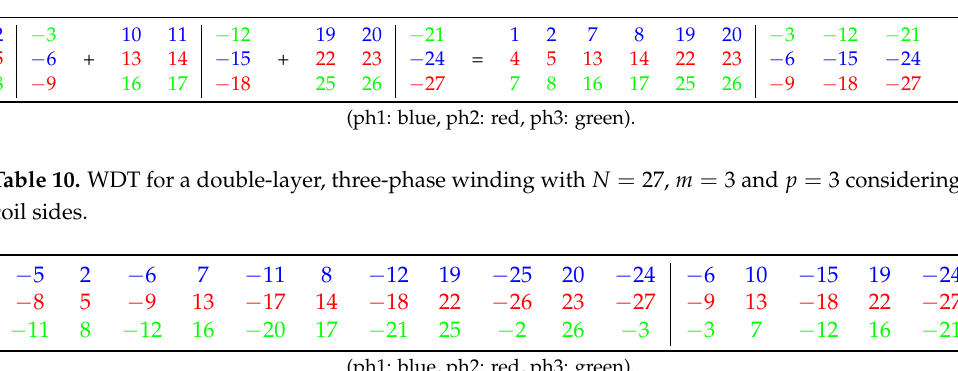
Figure 8. ( a ) Coil EMF star for a symmetrical double-layer coil winding and ( b ) winding scheme with series connected paths. N = 27, m = 3, p = 3, q = 1 + 1 / 2 and y c = 4. Table 9. WDT for a double-layer, three-phase winding with N = 27, m = 3 and p = 3.